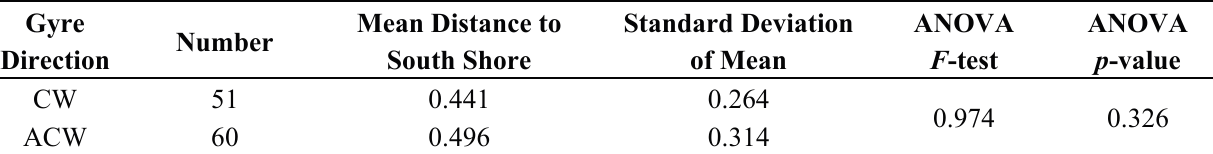
Table 8. Statistics of the locational difference of CW and ACW gyres within Teshekpuk Lake. Gyre